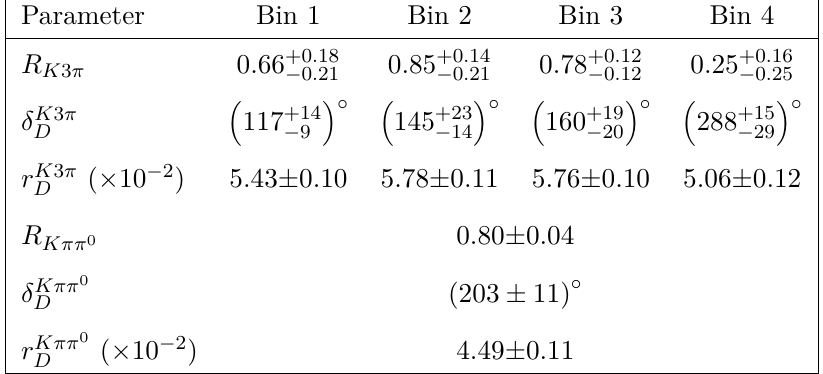
Table 21 . Results for the binned fit to the BESIII and CLEO-c data.